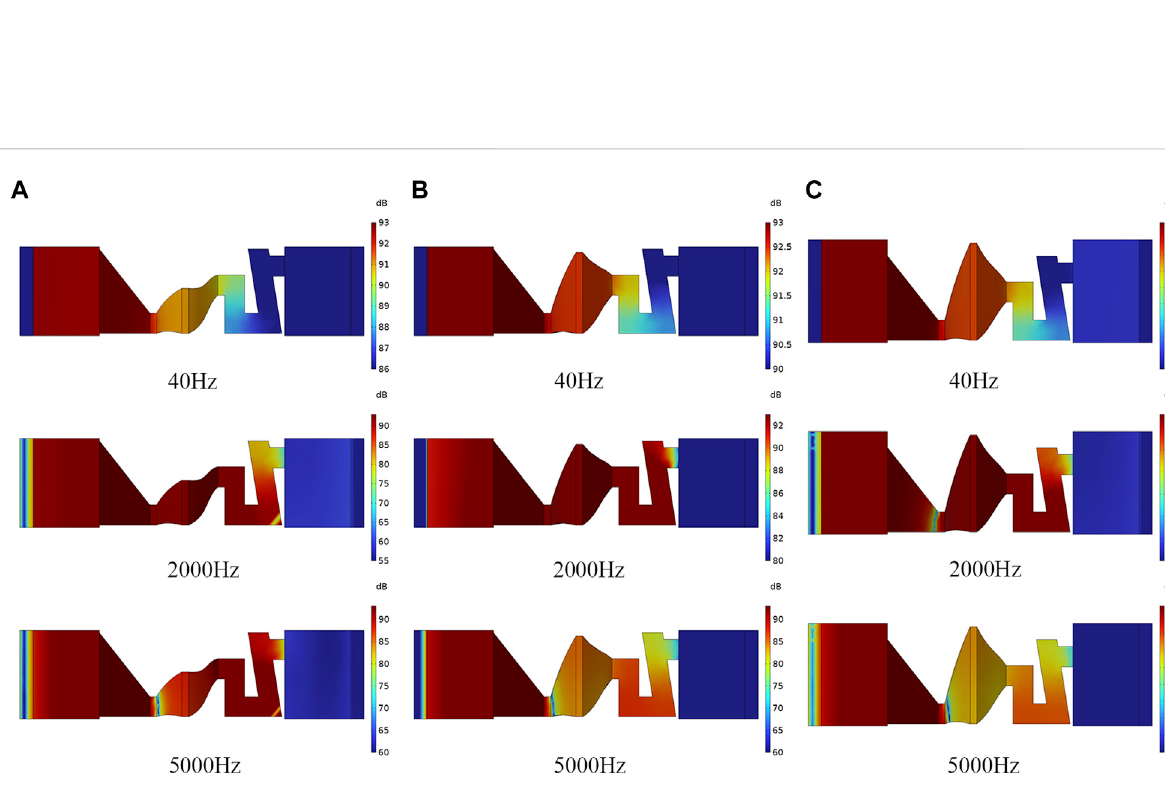
FIGURE 7 The sound pressure level at different frequencies in different models. (A) Model 1; (B) Model 2; (C) Model 3